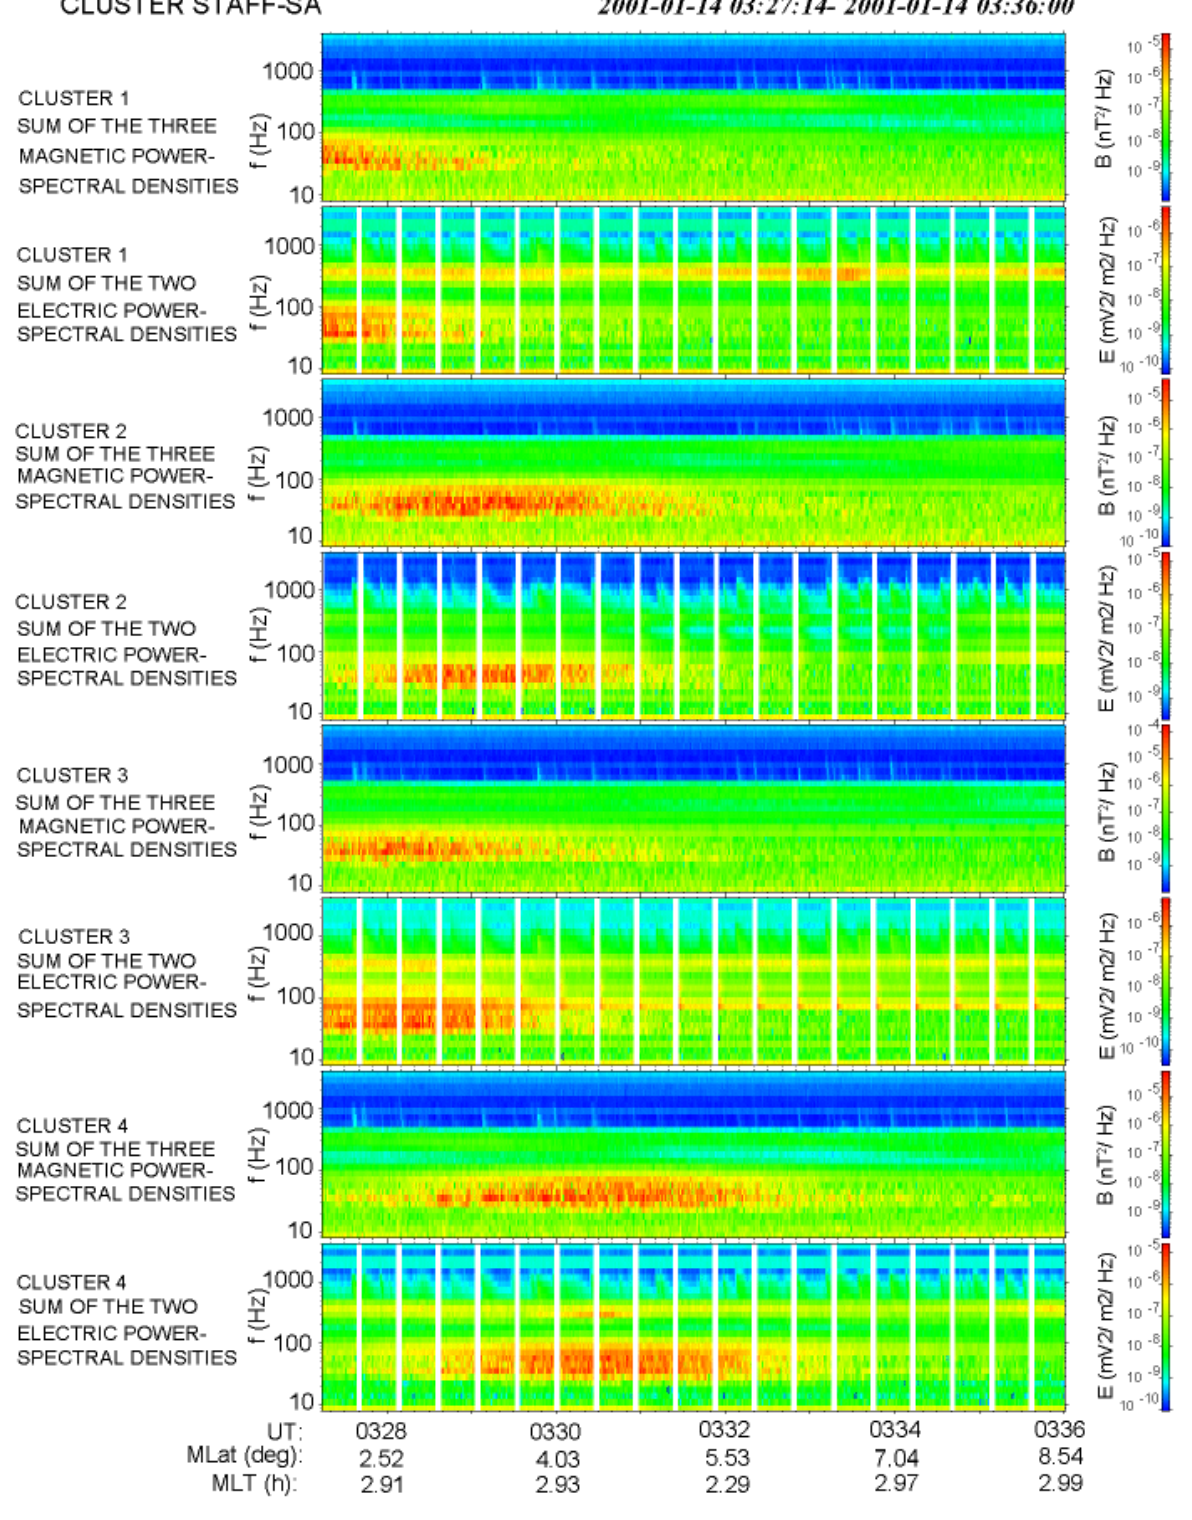
Fig. 7a. Spectrum Analyser dynamic spectra of total B- and E-power for the four spacecraft during a Cluster pass close to the perigee at 03 local time, and close to the magnetic equator. The magnetic latitude and the magnetic local time are given for spacecraft 3. The electromagnetic waves, identified as being sub-lhr hiss, are seen at different times by the four spacecraft, showing their strong